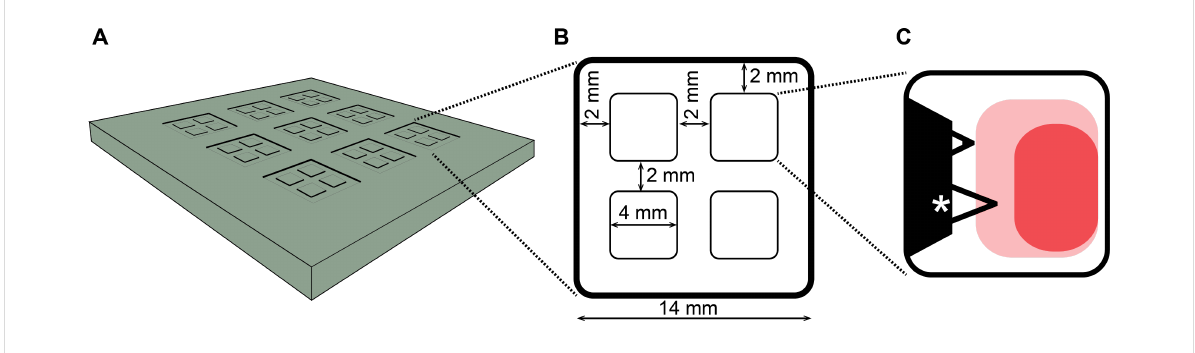
Figure 2: Technical details of the PDMS coating mask. (A) For the production of the PDMS masks, an aluminum mold is produced with nine casting molds for the PDMS masks. Dimensions of the masks are shown in (B). The height of the wells is 150 µm. (C) AFM cantilever (starred, NP-O, Bruker) accessible area usually used for SCFS adhesion experiments. Dark red indicates the area where the PDMS masks do not interfere with measure- ments, where the pale red area indicates regions where small interference occurs, and white areas are where measurements are not